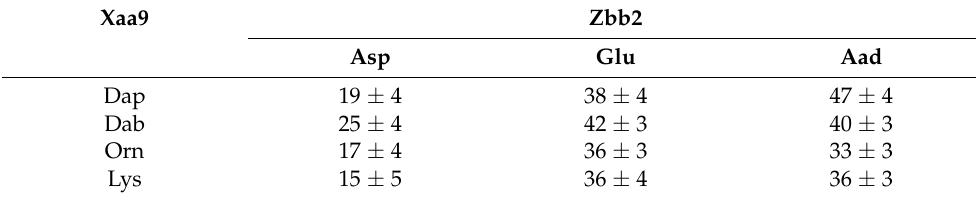
Table 3. The fraction folded population (%) for HPDZbbXaa peptides 1 .